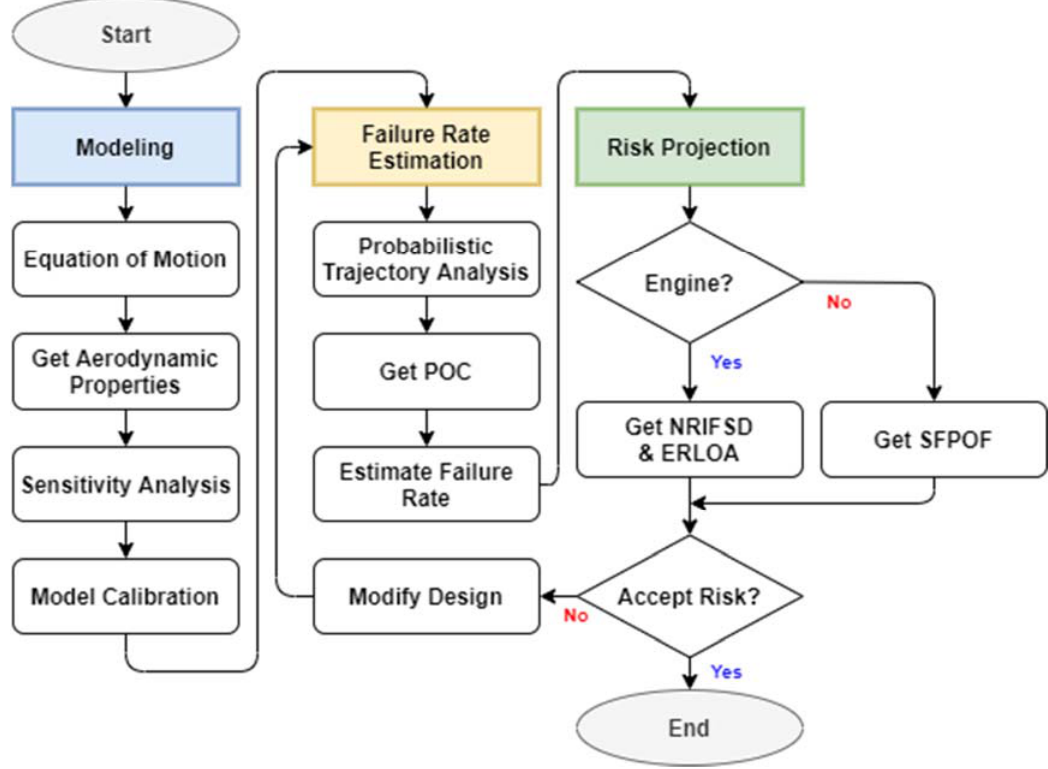
Figure 5. Flowchart for probabilistic risk analysis of aircraft self ‐ collisions.